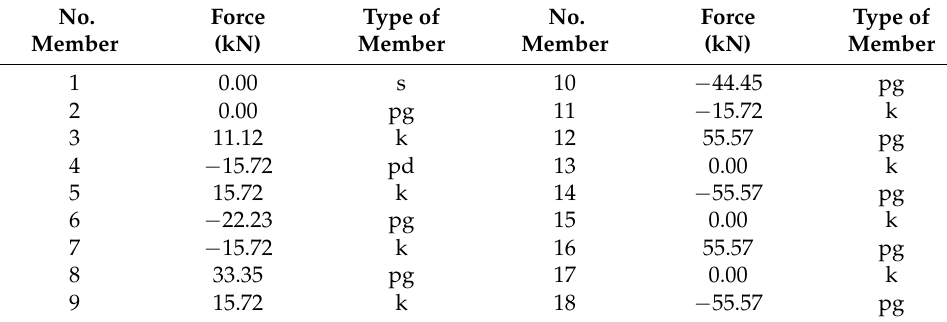
Table 3. Values of forces in bars—scheme B (Figure 3).